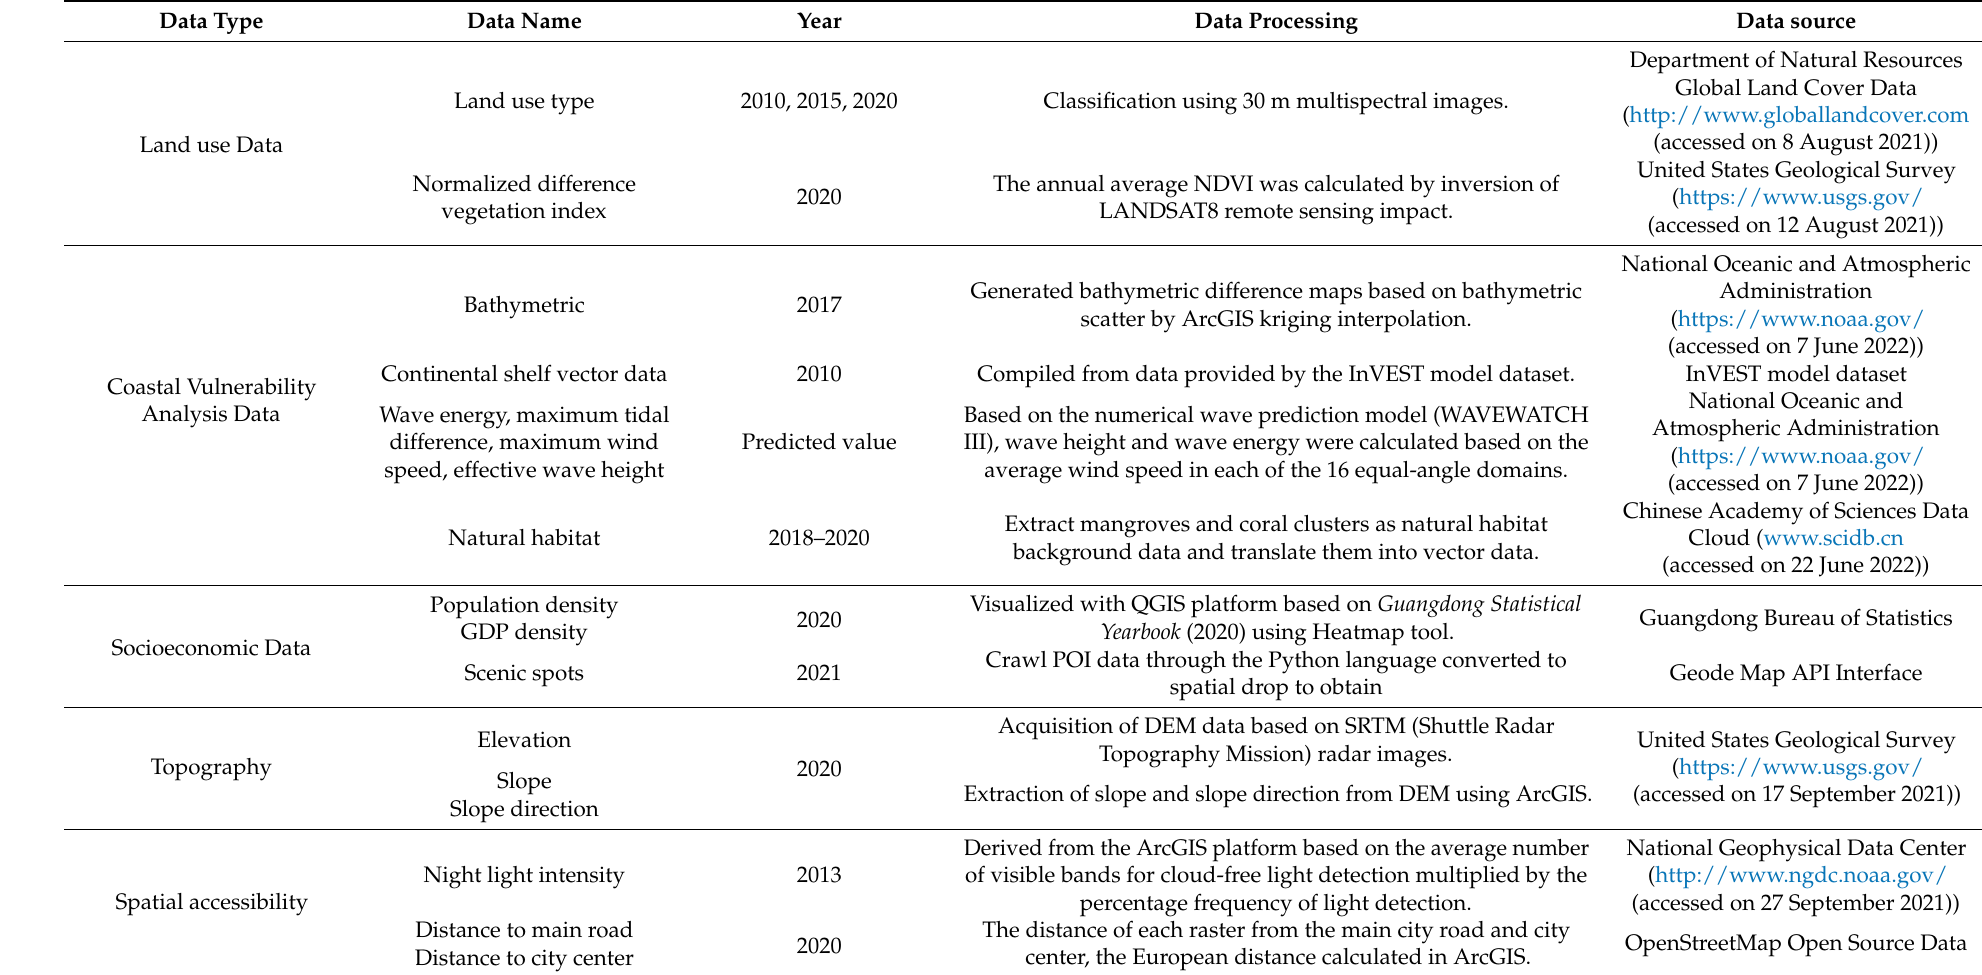
Table 1. Details of all the